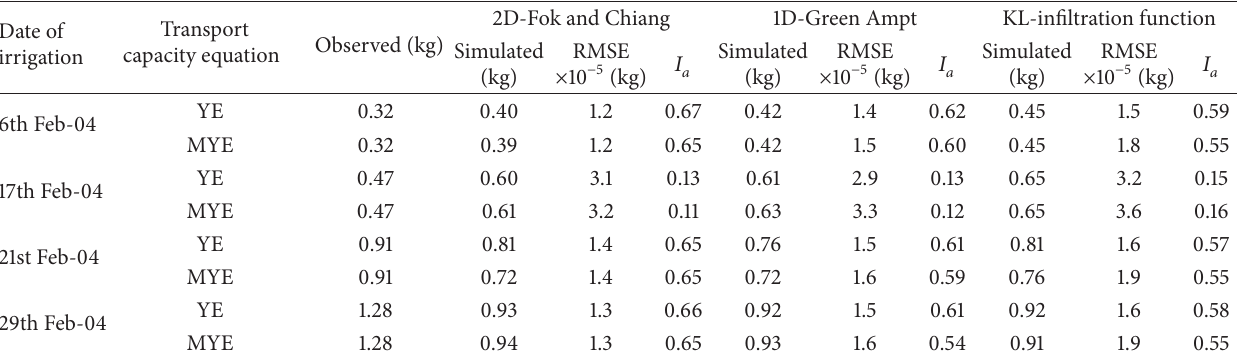
Table 2: Model performance for simulating sediment loss for bare